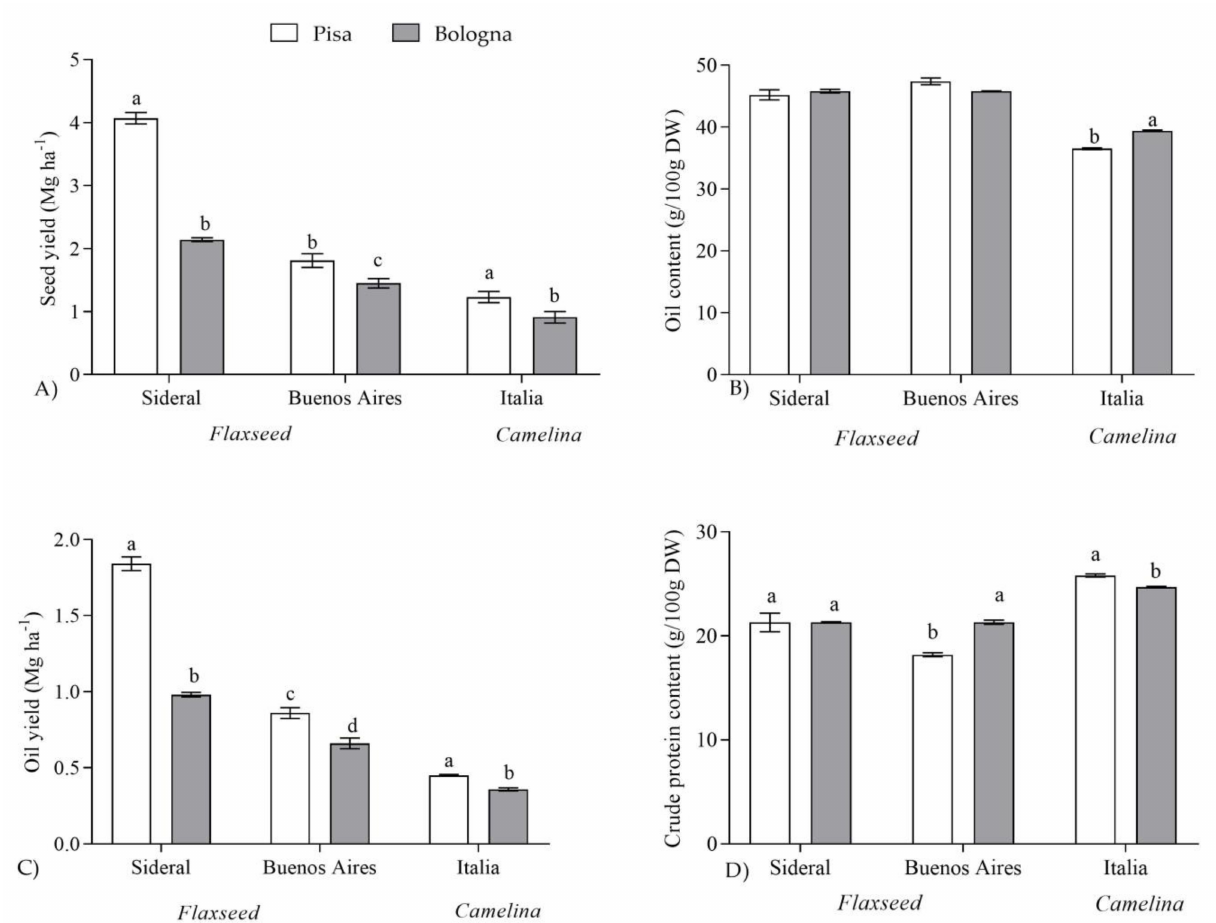
Figure 1. Seed yield ( A ), oil content ( B ), oil yield ( C ) and crude protein content ( D ) of the two oilseed crops (mean † ± SD) grown in two cultivation sites (Pisa and Bologna). † Values are the means of four replicates. Means followed by different letters are significantly different according to LSD 0.05 or Student’s t